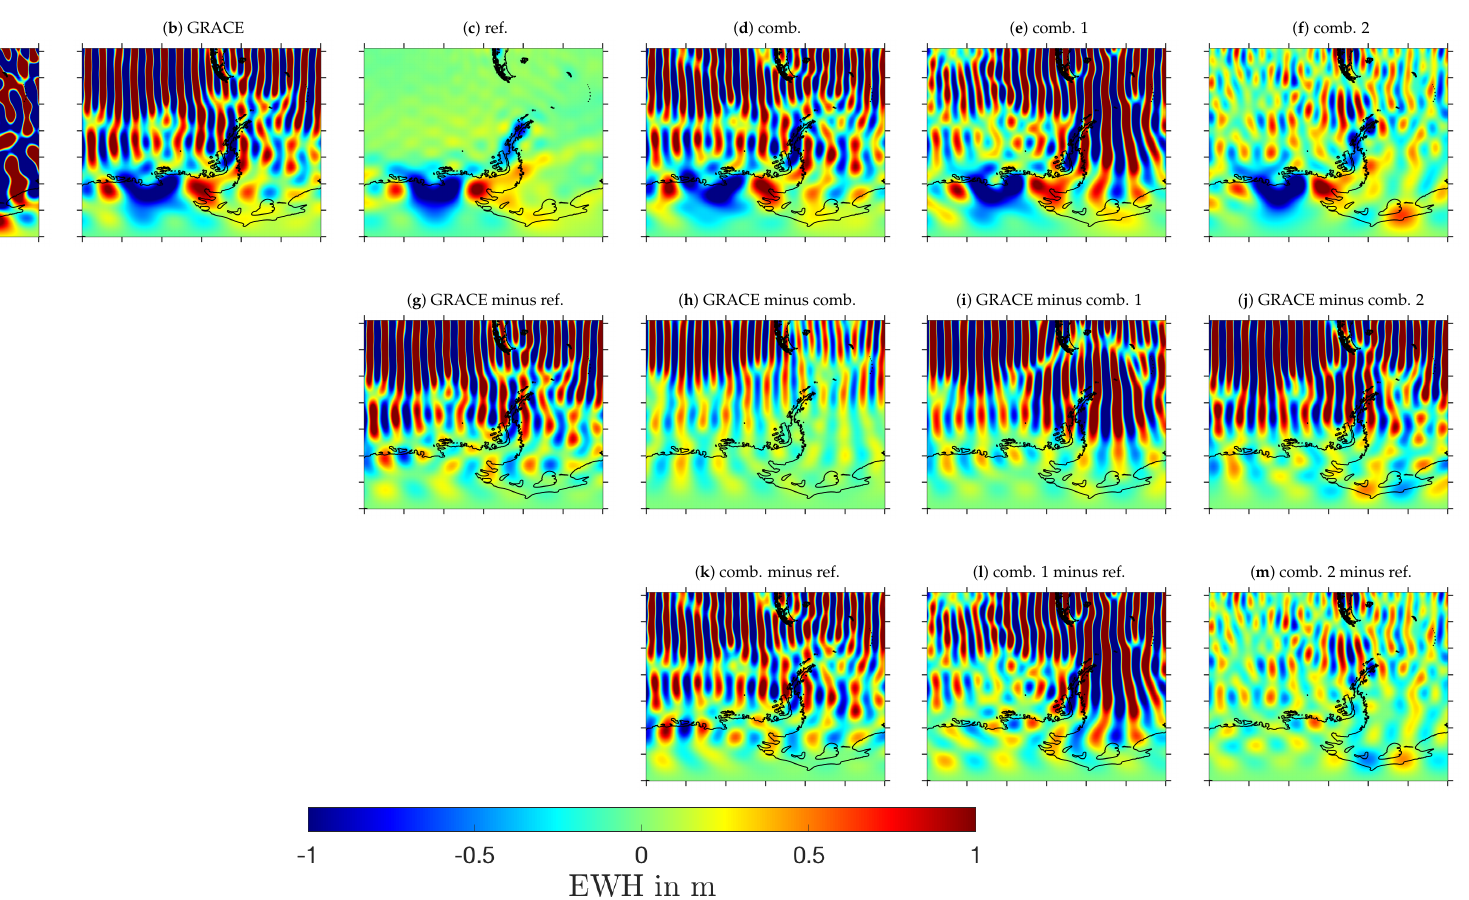
Figure 16. This figure is analogous to Figure 15, but shows the models and model differences as EWH grids in the region around West Antarctica. The x-axis denotes the longitude λ , with values from 220 ◦ to 340 ◦ , and the y-axis denotes the colatitude θ , with values from 140 ◦ to 175 ◦